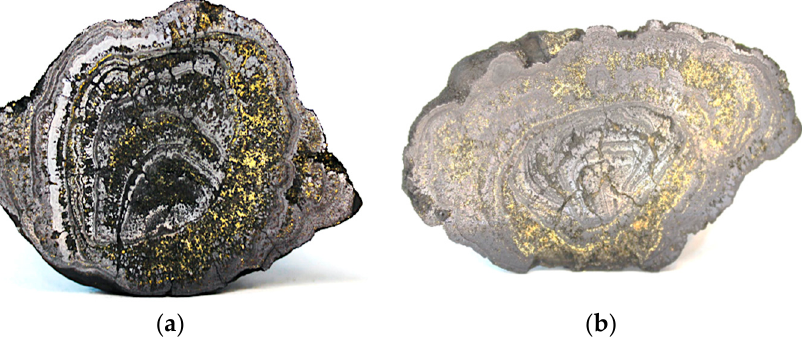
Figure 2. Examples of external views of polymetallic nodules.